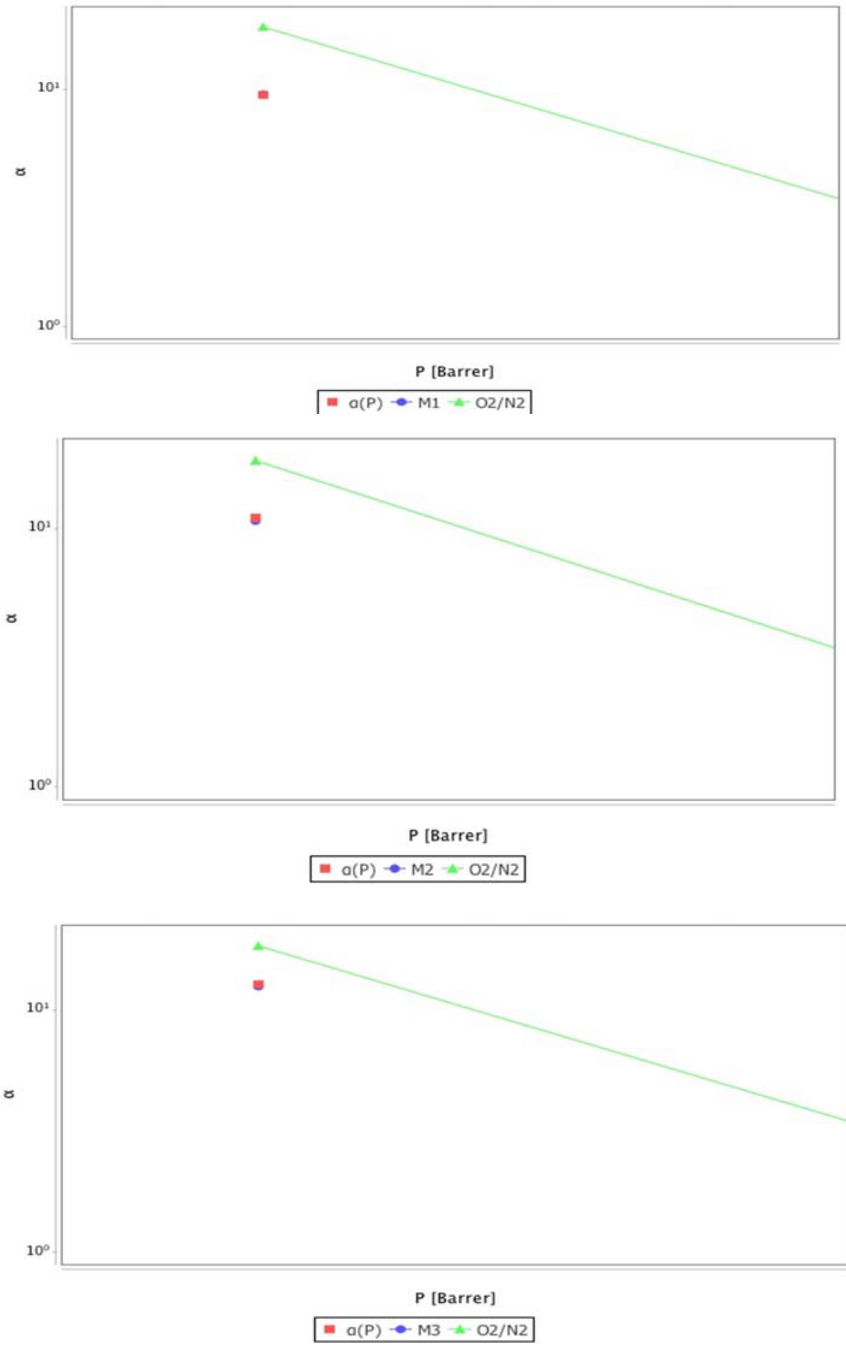
Figure 5. Comparison of experimental results (navy blue point) for the zeolite 4A-2, 2 ′ -BAPB + BPADA mixed-matrix membranes with 3 different filler additions (M1, M2 and M3) with Maxwell theoretical results (red point) and their position relative to the Robeson upper bound line (green line).